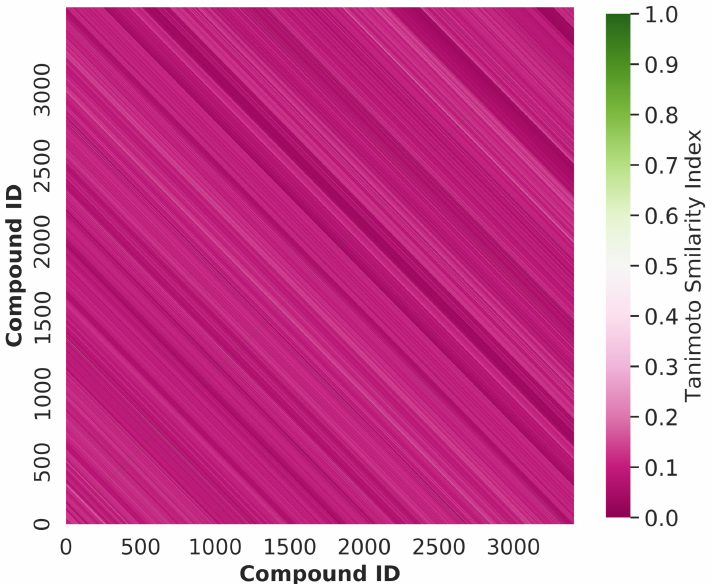
Figure 3. The heatmap represents the Tanimoto similarity index distribution of all compounds used in this study. The pink color represents the compounds with low similarity index, while the green color represents the compounds with high similarity